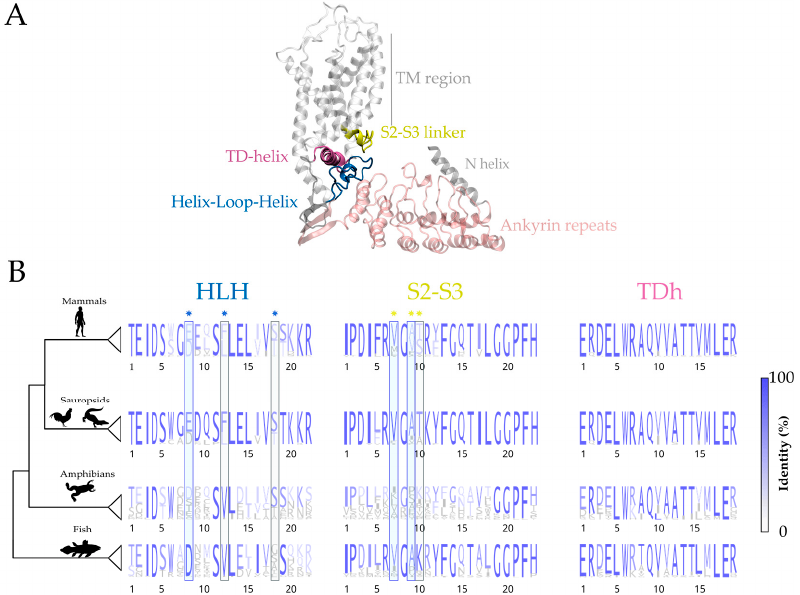
Figure 1. Helix-loop-helix (HLH) domain, S2-S3 linker, and TRP domain helix (TDh) show independent evolution patterns. ( A ) Structural model of one subunit of the human TRPV6 channel (hTRPV6, PDB:7S88). Ankyrin repeats domain (ARD, light pink), HLH domain (blue), S2-S3 linker (yellow), and TDh (mauve) are highlighted. TM region: transmembrane region, N helix: Amino-terminal helix. ( B ) Residue identity percent (in size and blue shades) for the components of the HLH/S2-S3 linker/TDh inactivation motif. Residues at the HLH domain (blue asterisks) and S2-S3 linker (yellow asterisks) previously shown as critical for TRPV6 fast inactivation are highlighted. Shadows represent functionally relevant amino acids not conserved (gray) and conserved (blue) in amphibians and/or fish compared to sauropsid and mammalian homologs. Multiple sequence alignment in Supplementary Figure S1 was used to calculate the percentage of amino acid identity.